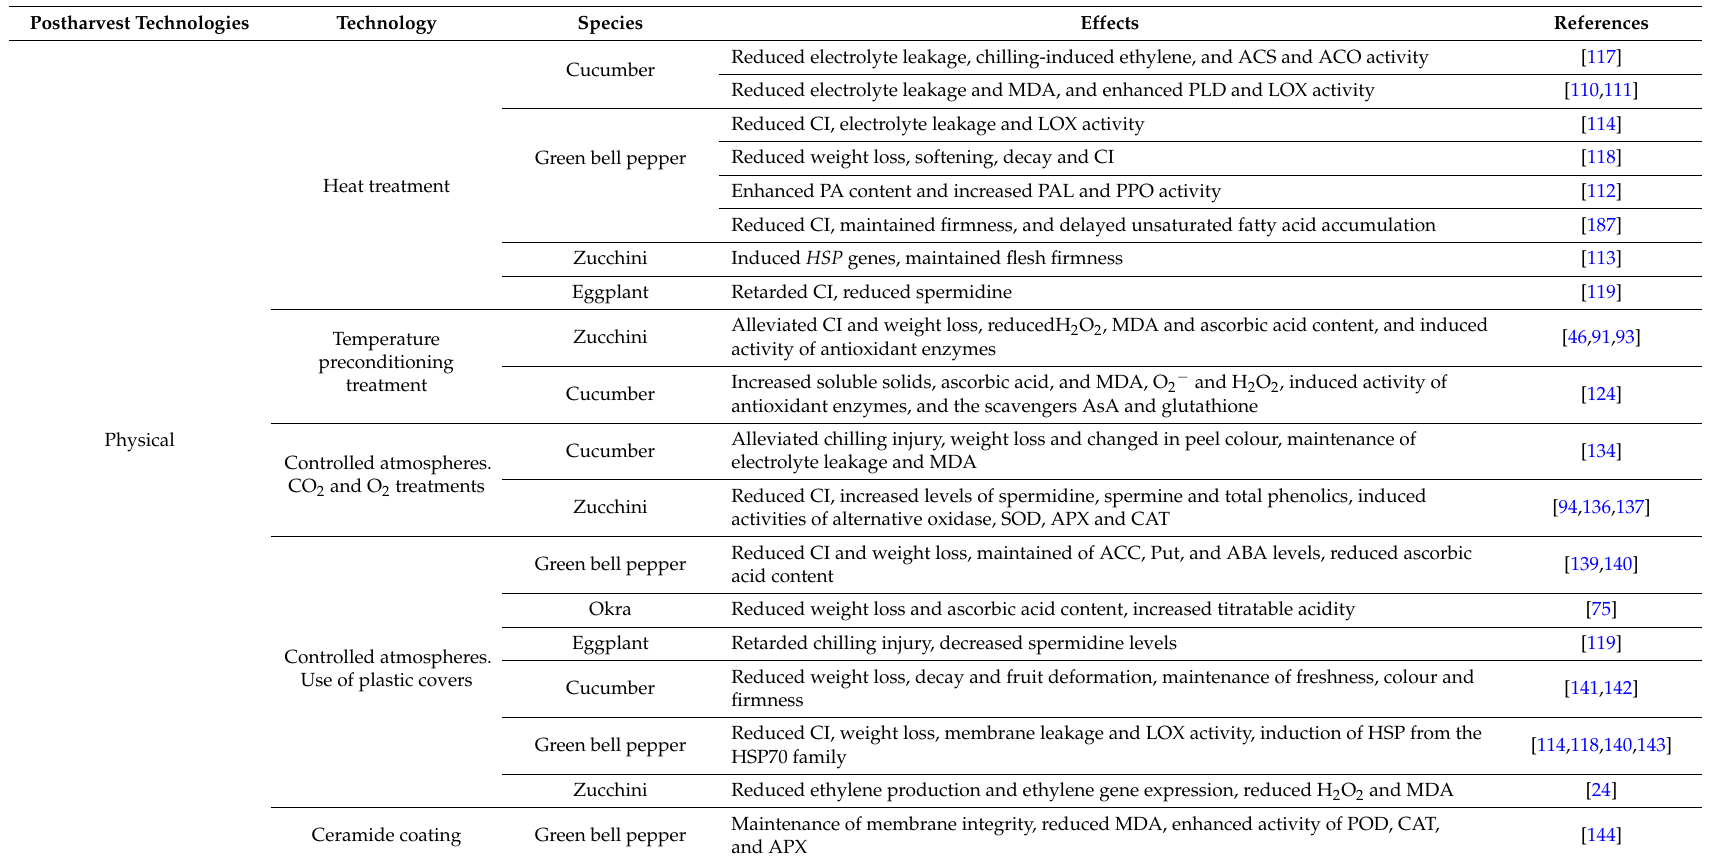
Table 2. Postharvest treatments alleviating oxidative stress and CI in immature